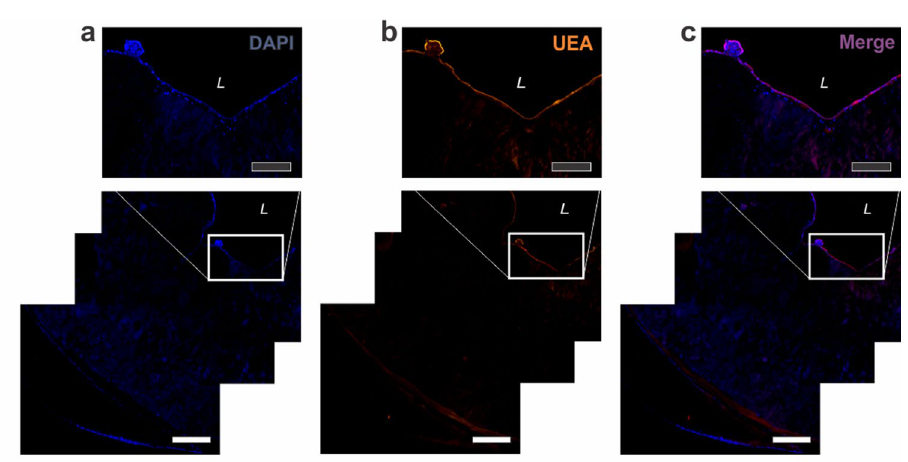
Figure 11. Endothelialization of Alloderm-integrated vessels. Vessel lumen was successfully endothelialized with human umbilical cord endothelial cells (HUVECs). UEA-1 stain showed complete coverage of the vessel lumen with HUVECs. Black scale bars = 500 µm; white scale bars = 200